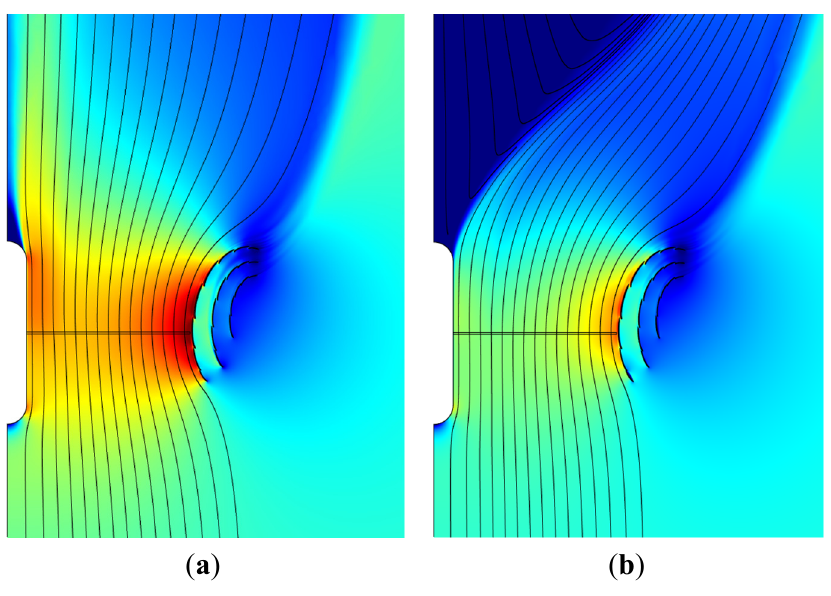
Figure 20. Axial velocity and streamlines. ( a ) TSR = 2, C C (cid:3404) 0.89 . Multi-element DAWT. Nacelle/rotor: Centerbody with cylindrical root (cid:2904)